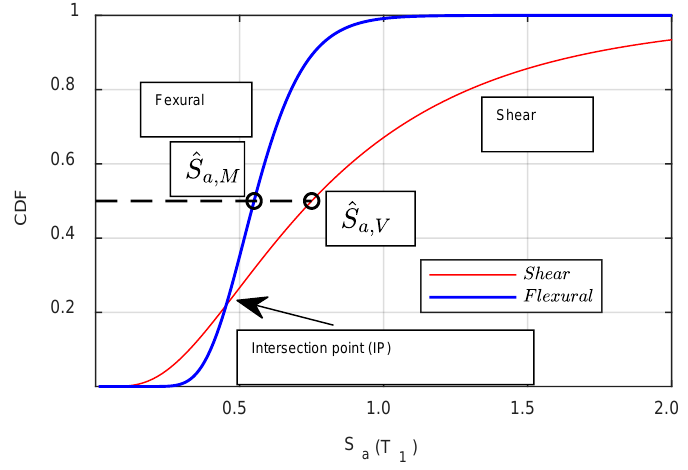
Figure 3. Shear and flexural failure mechanism probability distribution.